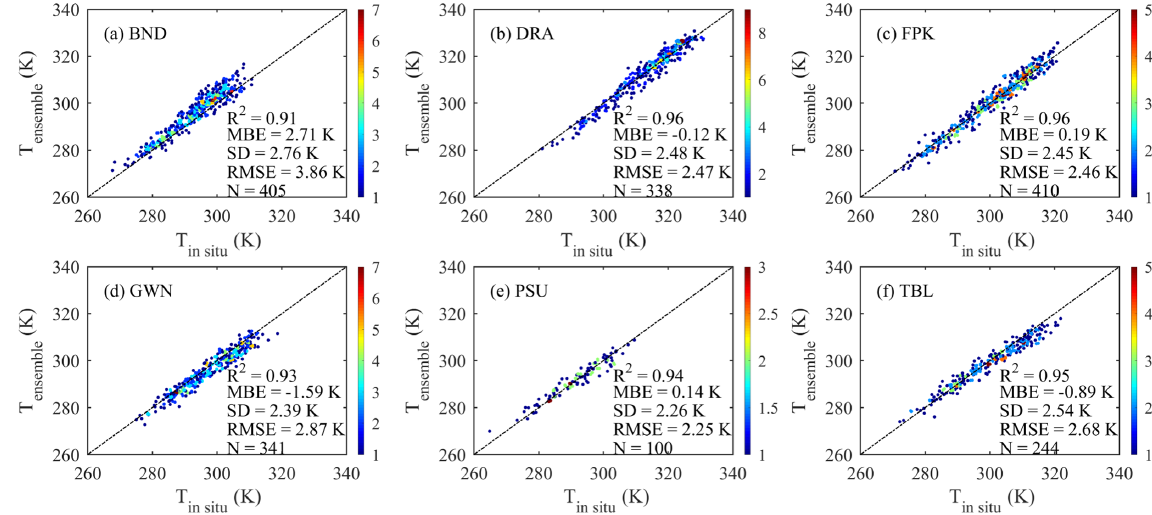
Figure 8. RF-SWA LST against in situ LST from SURFRAD sites.